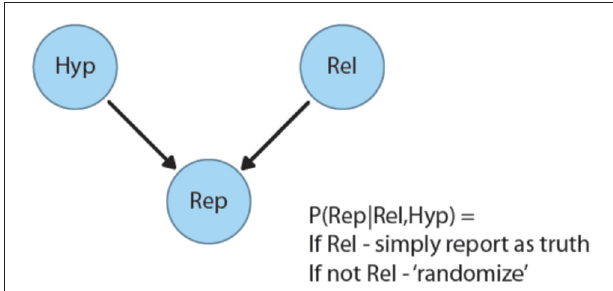
2 Bayesian belief networks are graphical models that simplify Bayesian computations by characterizing independence relations between variables. Nodes represent variables; links represent dependencies between variables, typically causal connections. For an introduction see e.g., (Korb and Nicholson,